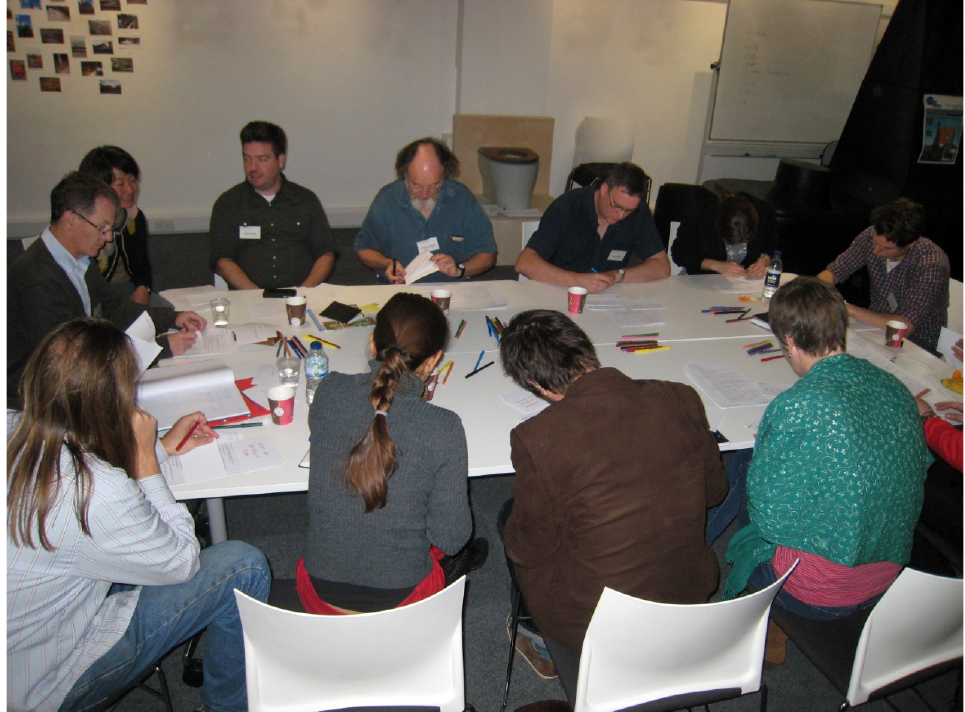
Figure 1. Participants playing Macromoves. Introductory photo wall in the background. Photograph by Danielle